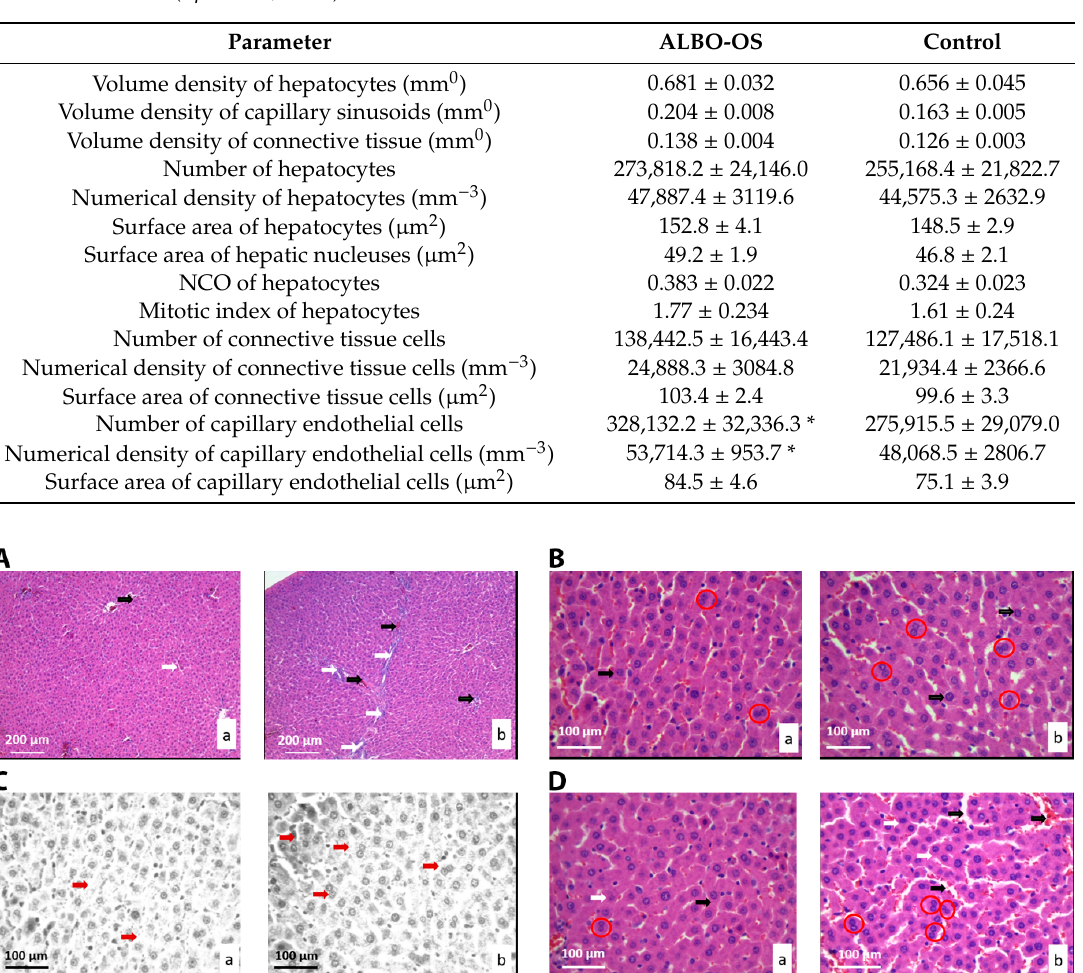
Table 4. Stereological parameters of kidneys of the control group and treated group of rats; values are shown as mean ± SD (* p < 0.05; t -test).